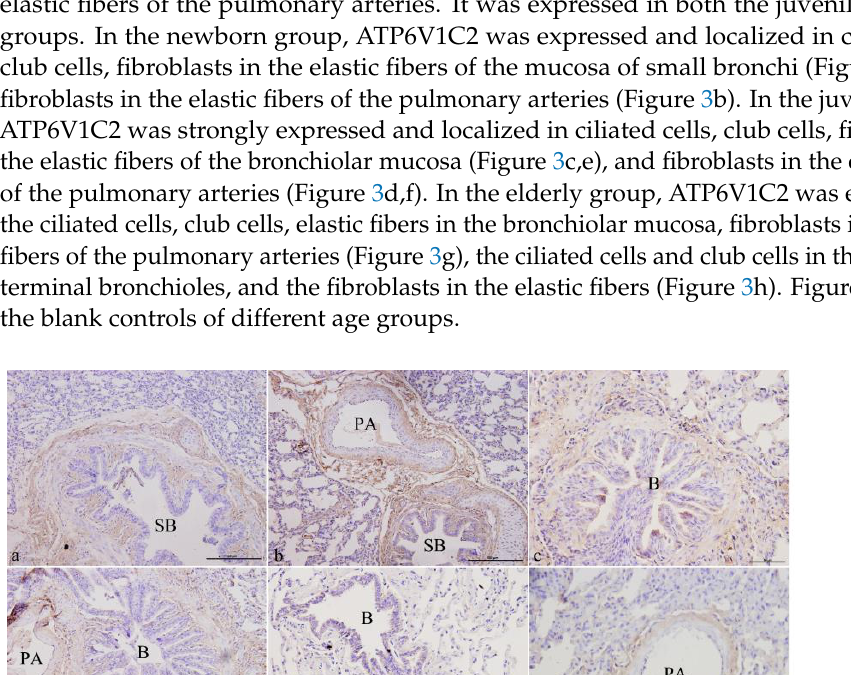
Figure 3. ATP6V1C2 localization in yak lungs at different ages. ( a ) Small bronchi of yak lungs in the newborn group (200×). ( b ) Small bronchi and pulmonary arteries of yak lungs in the newborn group (200×). ( c ) Bronchioles of yak lungs in the juvenile group (400×). ( d ) Bronchioles and pulmonary arteries of yak lungs in the juvenile group (400×). ( e ) Bronchioles of yak lungs in the adult group (400×). ( f ) Pulmonary arteries of yak lungs in the adult group (400×). ( g ) Bronchioles and pulmonary arteries of yak lungs in the elderly group (400×). ( h ) Terminal bronchioles of yak lungs in the elderly group (400×). ( i ) Blank control of small bronchi and pulmonary arteries of yak lungs in the newborn group (200×). ( j ) Blank control of bronchioles and pulmonary arteries of yak lungs in the juvenile group (200×). ( k ) Blank control of bronchioles of yak lungs in the adult group (200×). ( l ) Blank control of bronchioles of yak lungs in the elderly group (200×). SB — small bronchi; B — bronchiole; TB — terminal bronchiole; PA — pulmonary artery. 3.2. Fluorescence-Based qRT-PCR After the conventional PCR amplification, the PCR products were separated by 2% agarose gel electrophoresis to obtain a single band that matched with the expected band (Figure 4). Using qRT-PCR to detect the expression of CFTR, ATP6V0D2 and ATP6V1C2 in the yak lungs at different ages, with single melting curve peaks and primer specificity meeting the test requirements (Figure 5). The results showed that the mRNAs of CFTR, ATP6V0D2 and ATP6V1C2 were expressed to varying degrees in the yak lungs at differ- ent ages. The mRNA expression of CFTR was the highest in the adult group followed by the elderly group, and the mRNA expression of CFTR was the lowest in the yak lungs of the juvenile group. The mRNA expression of CFTR varied significantly among different ages ( p < 0.05). The mRNA expression of ATP6V0D2 was the highest in the newborn group and showed significant differences between the newborn and the juvenile groups ( p < 0.05) and between the juvenile and adult groups ( p < 0.05), but not between the adult and elderly groups ( p > 0.05). The mRNA expression of ATP6V1C2 in different age groups showed the same trend as the mRNA expression of CFTR (Figure 6).